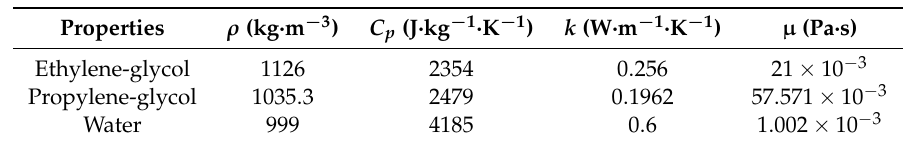
Table 3. Thermophysical properties of ethylene- and propylene-glycol compared to those of water at 20 ◦